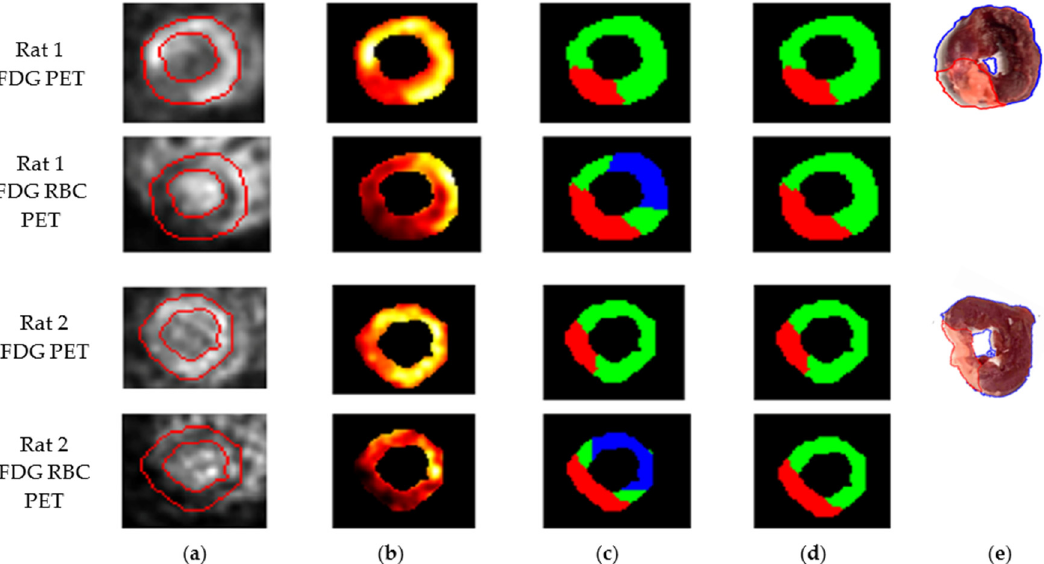
Figure 6. Two consecutive short axis views of the left ventricle from two representative myocardial infarction rats on metabolic FDG PET images and FDG RBC PET images. ( a ) LV myocardial segmentation on PET images. ( b ) Color heat map PET images of segmented LV. ( c ) Three-color stratified FDG RBC PET images (low = red, medium = green, high = blue) of tracer activity. ( d ) Two-color stratified PET image (red = infarct; green = viable). ( e ) TTC tissue viability staining of transverse slices of the LV myocardium from the same infarction rats. There is significant scar tissue and/or atrophy in the infarcted portion of the LV wall (red outline) of some of the rats compared to the uninjured myocardium (blue outline). Dark red tissue = viable myocardium. Tan tissue = infarcted myocardium. Total rats = 6. Table 1. Results of mean infarction size measurement based on FDG RBC PET images, FDG PET images, and TTC pathology staining.